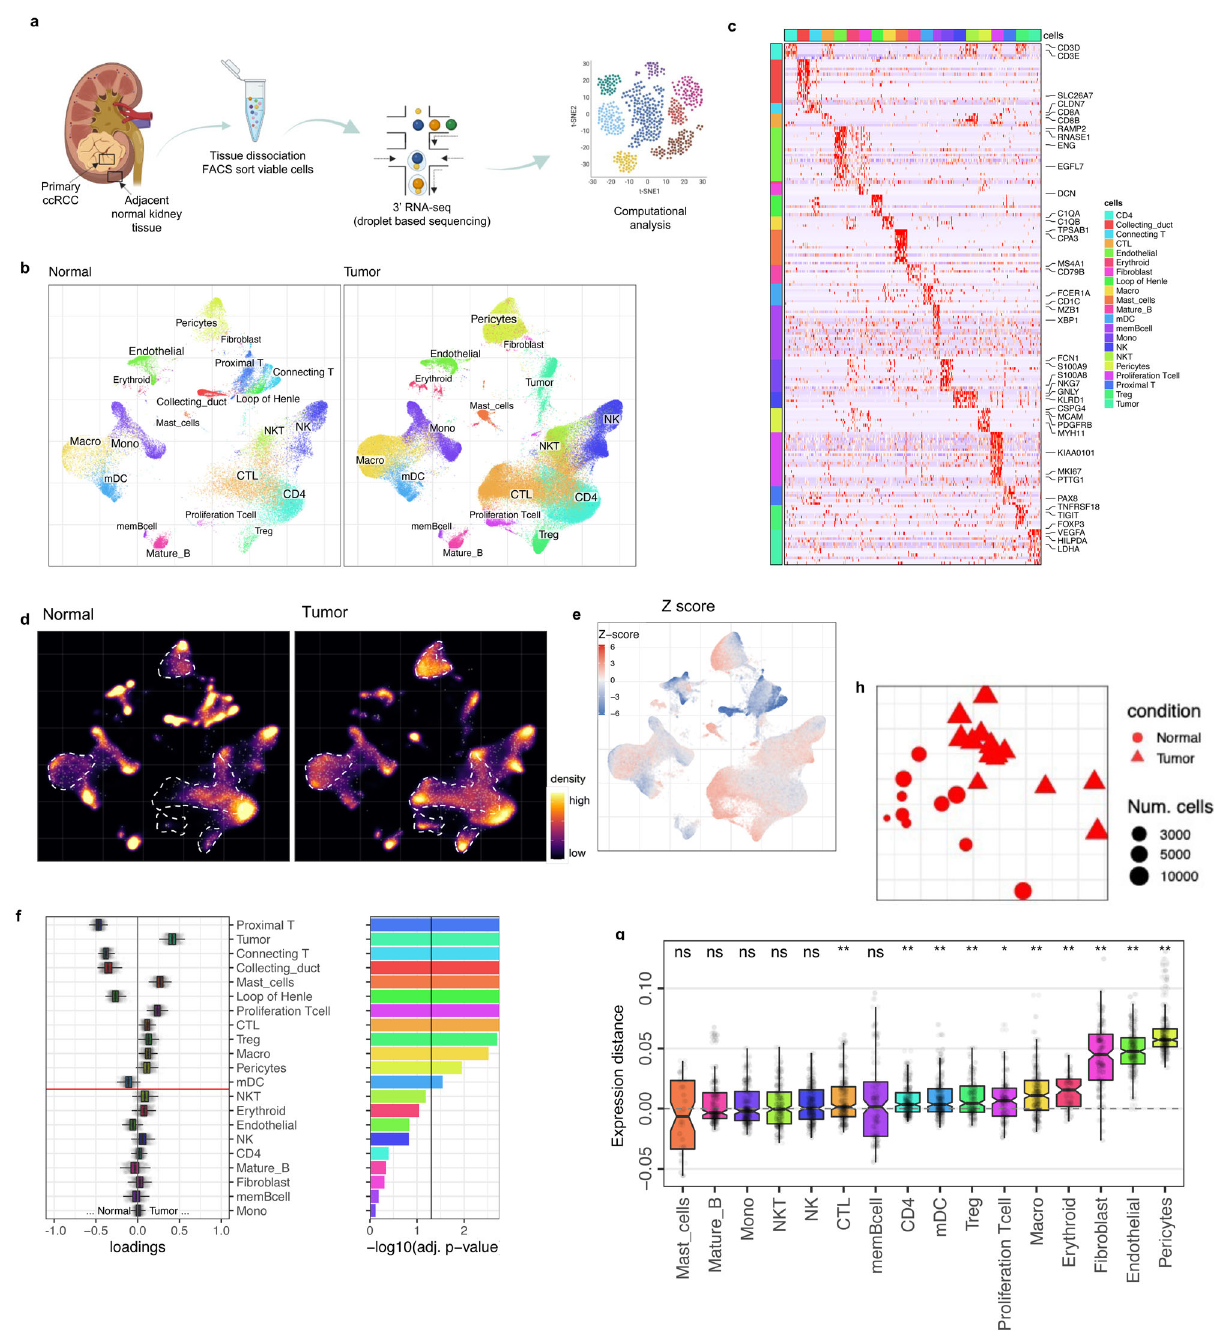
Fig. 1 | Single-cell landscape of the ecosystem in primary ccRCC and adjacent normal tissue. a Experimental design created with Biorender.com and Adobe Illustrator. b Integrative analysis of scRNA-seq samples from 26 RCC samples, visualized using a common UMAP embedding for adj-normal (left) and tumor kidney tissue (right). c Heatmap showing expression of markers for major cell populations. d Changes in the composition of all compartments combining all sample fractions and is visualized as cell density on the joint embedding. e Statistical assessment of the cell density differences comparing tumor with adjacent normal. A two-side Wilcoxon test was used, visualized as a Z score. Red indicates increased cell abundance in tumor, blue indicates decreased cell abundance in tumor. f Change in cell composition evaluated by Compositional Data Analysis. The x -axis indicates the separating coef fi cient for each cell type, with the positive values corresponding to increased abundance in tumor, and negative to decreased abundance. The boxplots and individual data points show uncertainty based on bootstrap resampling of samples and cells (see Methods). Boxplot includes center line: median; box limits: upper and lower quartiles;